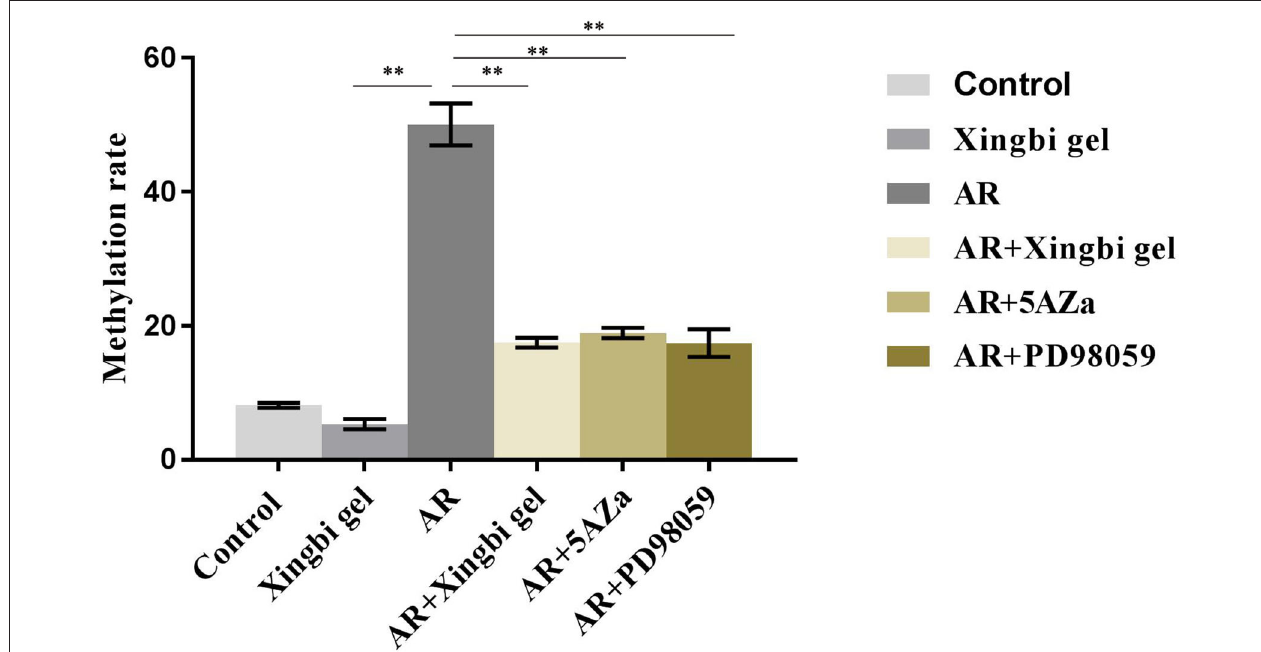
FIGURE 4 | Xingbi gel, PD98059 and 5Aza reduces the IFN- γ gene promoter methylation